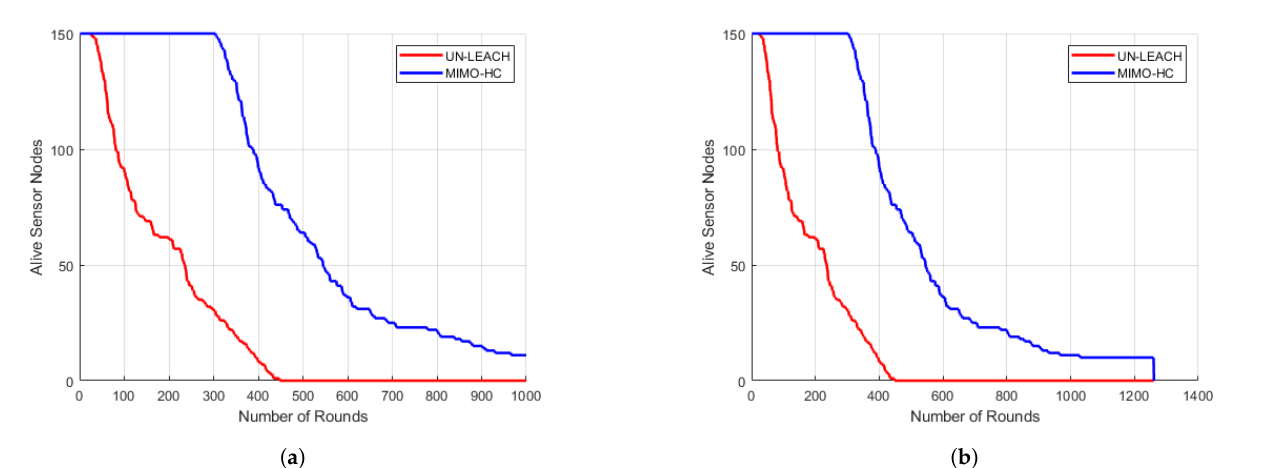
Figure 12. Network lifetime. ( a ) Time when first node perishes; ( b ) Time when last node